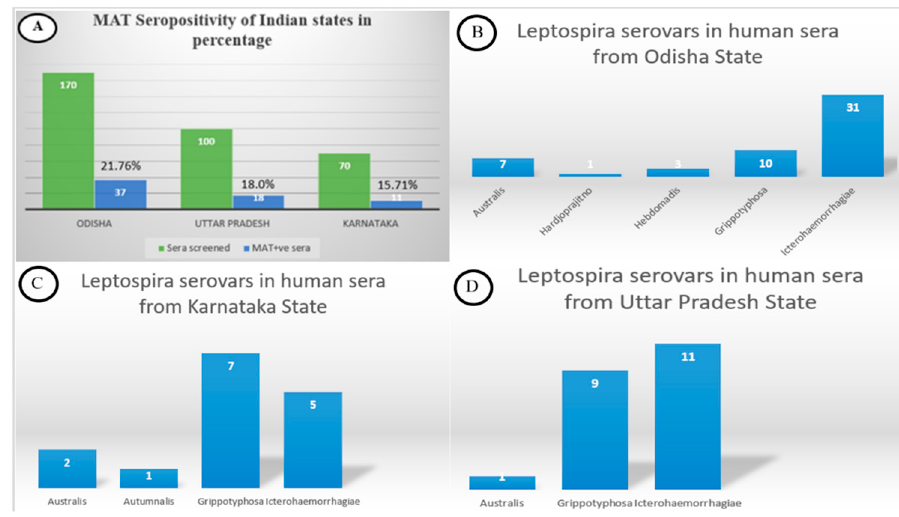
Figure 1. MAT seropositivity of Indian states in percentage and Leptospira serovar epidemiology in Indian states such as Odisha, Karnataka and Uttar Pradesh.